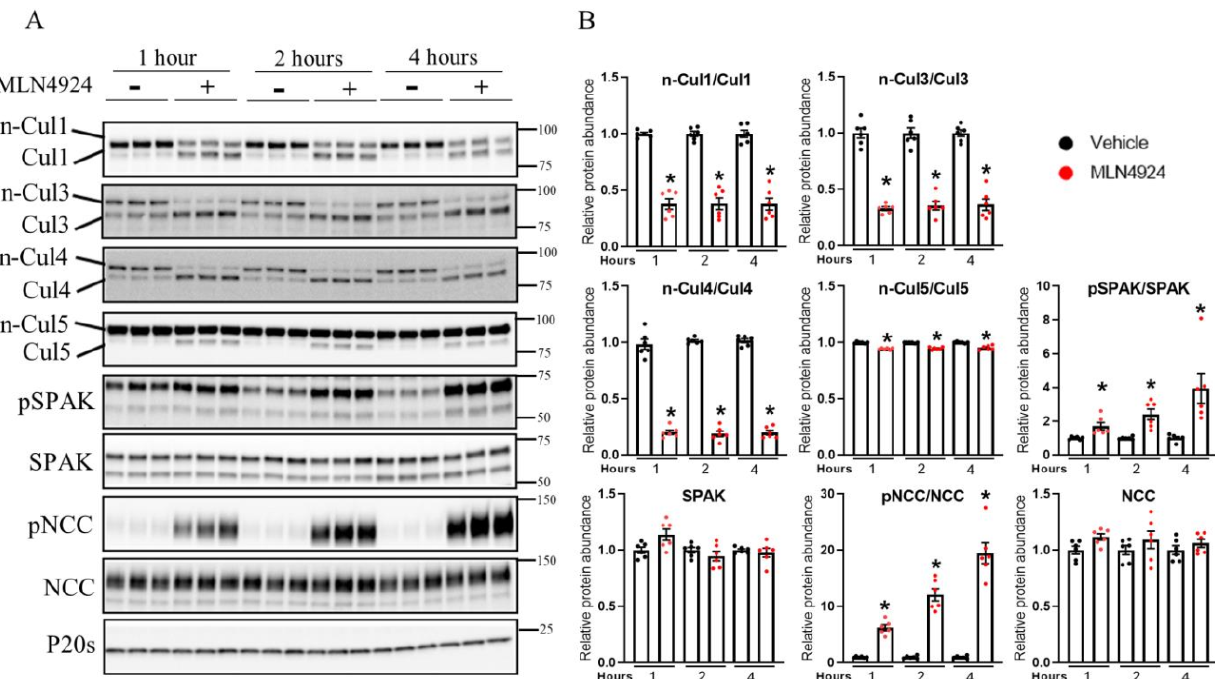
Figure 5. Pharmacological inhibition of cullin neddylation increases NCC phosphorylation in isolated renal tubules ex vivo. ( A ) Representative immunoblots of Cul1, Cul3, Cul4, Cul5, pSPAK, SPAK, pNCC, NCC, and P20s in isolated renal tubules that were incubated with either vehicle or the cullin inhibitor (MLN4924; 0.5 uM) for various time points (1, 2, or 4 h) ex vivo. Molecular weight markers (kDa) are shown on the right. ( B ) Summarized relative protein abundance data. Each dot represents value from an individual well of independent tubules and each bar represents mean ± SEM obtained from two independent experiments ( n = 6). * indicates p < 0.05 relative to 3.5 mM condition.